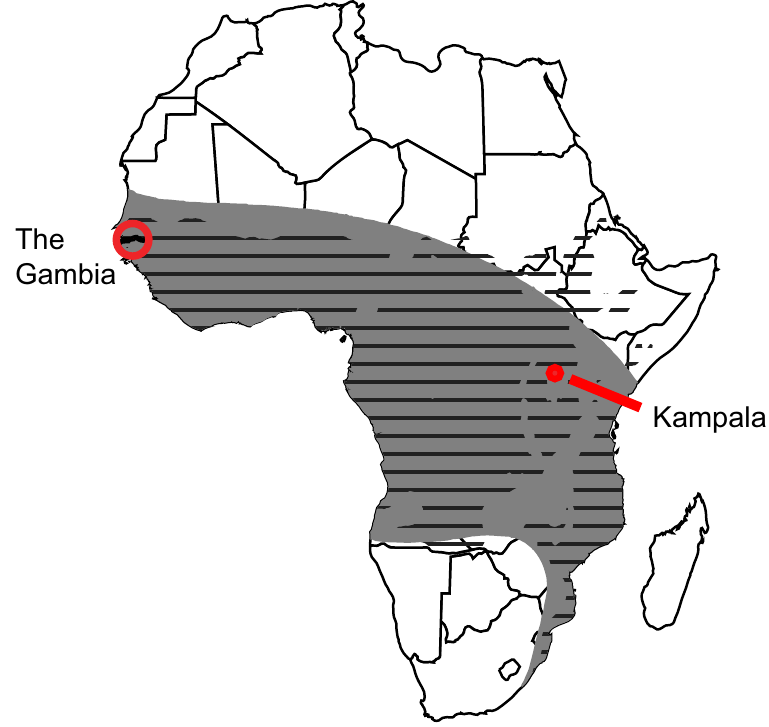
Figure 1. The Burkitt lymphoma belt overlaps the regions of Africa in which malaria is holoendemic. The grey belt shown on the map of Africa represents the areas in which Denis Burkitt’s surveys found Burkitt lymphoma to be endemic. The black horizontal stripes represent regions of Africa in which the temperatures and rainfall support holoendemic malaria. Kampala is where Denis Burkitt treated his patients; the Gambia is one site where the role of malaria as a cofactor for causing Burkitt lymphoma was demonstrated.